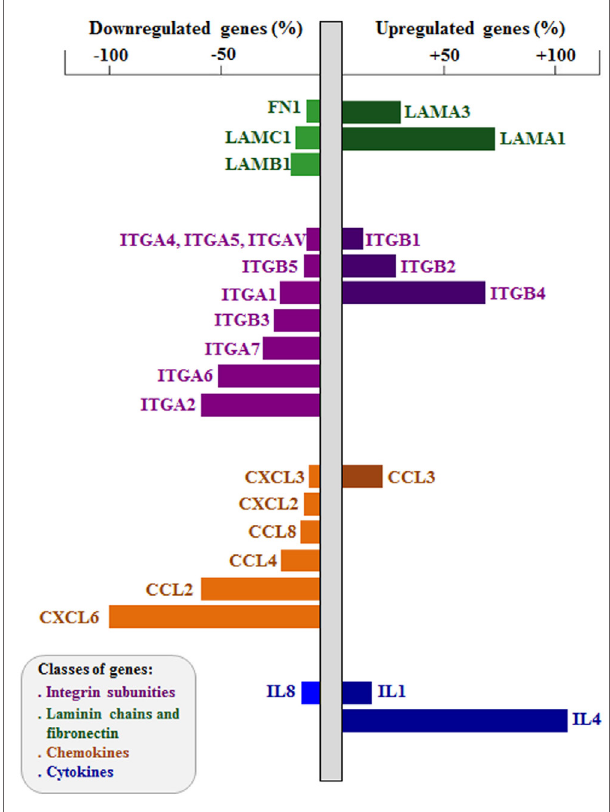
FiGURe 2 | effects of integrin α 6 knockdown on cell adhesion and migration-related genes of human thymic epithelium . The figure shows extracellular matrix and chemokine ligand genes up- and downregulated after integrin α 6 (ITGA6) knockdown by small interference RNA (siRNA) strategy. Gene expression was defined using PCR arrays, comparing ITGA6 siRNA-treated thymic epithelial cells ( n = 5) with control siRNA cells ( n = 5). Bar colors indicate different group of genes (LM chains and FN in green , integrin sub-unities in purple , chemokines in orange and cytokines in blue ). Right bars are upregulated genes and left bars are downregulated genes, both showed in percentage. Two-tailed unpaired Student’s t -test was applied, and the differences showed were all significant. Data derived from Ref.